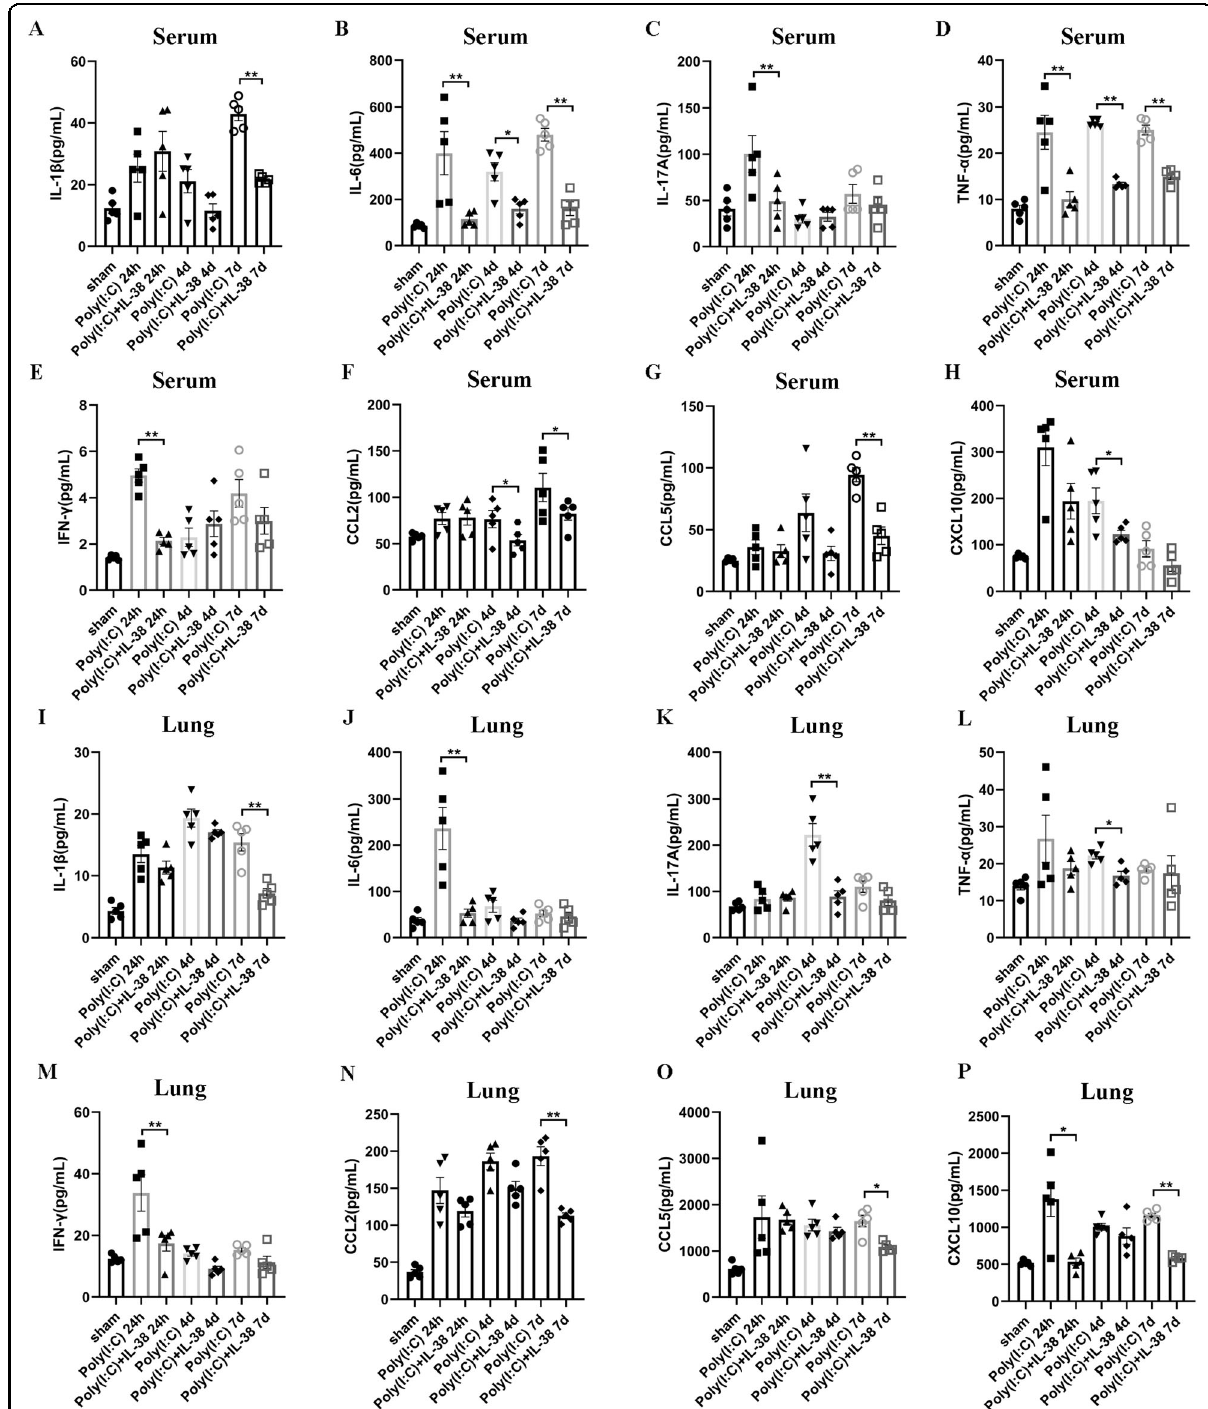
Fig. 5 IL-38 reduces cytokine and chemokine production during poly(I:C)-induced lung injury. Serum and lung homogenates ( n = 3 – 5 each group) were collected on day 1, 4, and 7 after poly(I:C) injection. Each symbol represents an individual mouse. Speci fi c cytokines and chemokines in the serum ( a – h ) and lung ( I – P ) were measured with Mouse Cytokine Milliplex MAP assay kit or LEGENDplex ™ kits at indicated times, respectively. Bars represent the mean from at least three different experiments (± SEM). Mann – Whitney test was used to compare the differences between groups. * p < 0.05, ** p < 0.01, and *** p <